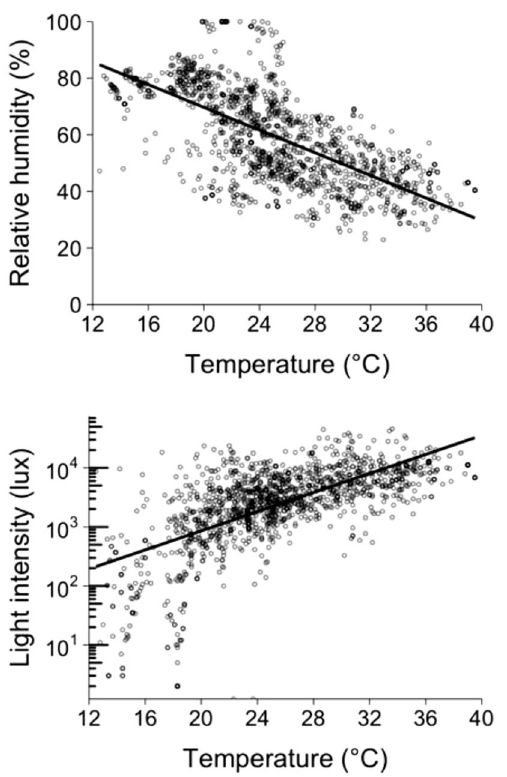
Figure 2. The relationships of relative humidity and light intensity to temperature for randomly measured leaves throughout the canopy.